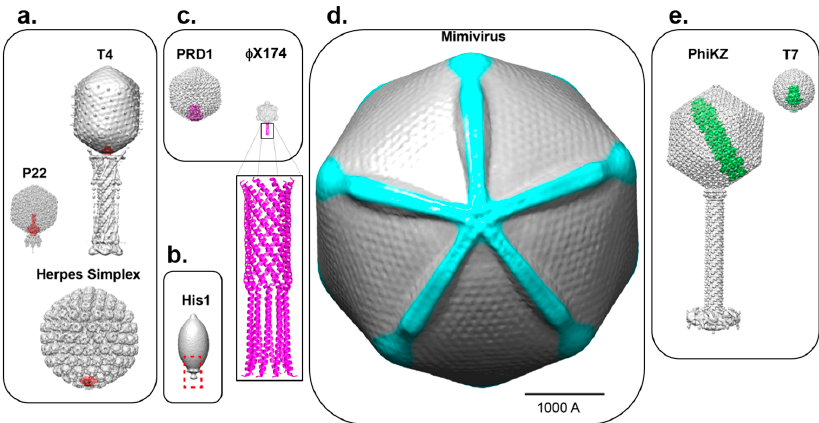
Figure 2. Asymmetric cryo-EM reconstructions of bacterial, archeal and eukaryotic viruses with unique vertices. ( a ) The portal protein (colored in red) occupies of a 5-fold vertex of the icosahedral capsid in P22 (EMD-8005), T4 (EMD-2774) and HSV-1 (EMD-5255). ( b ) The lemon-shaped archeal virus His1 is shown with solely the capsid structure from cryo-EM (EMD-6223) and a red dashed box highlighting the unique vertex; currently no portal or other data are available for this unique assembly site. ( c ) Two examples of viruses with unique vertices (in magenta) induced upon genome ejection: PRD1 (EMD-5984) and Ф X174 (EMD-7033). For the latter, the crystallographic structure of the H-protein (PDB 4JPP) is modeled to scale at a 5-fold vertex and is also shown enlarged. ( d ) The Mimivirus capsid (EMD-5039) is rendered with density for the starfish seal highlighted in cyan and is rotated 90° to view down the axis containing the unique vertex. ( e ) The inner body and inner core proteins of phages PhiKZ (EMD-1415, EMD-1996) and T7 (EMD-5568) are shown in green inside their respective capsids. All viruses in Figure 2 are shown in scale (the scale bar is 1000Å). Table 2. Inventory of asymmetric cryo-EM and cryo-electron tomography (cryo-ET) structures of DNA bacteriophages that contain protein complexes that break icosahedral symmetry.